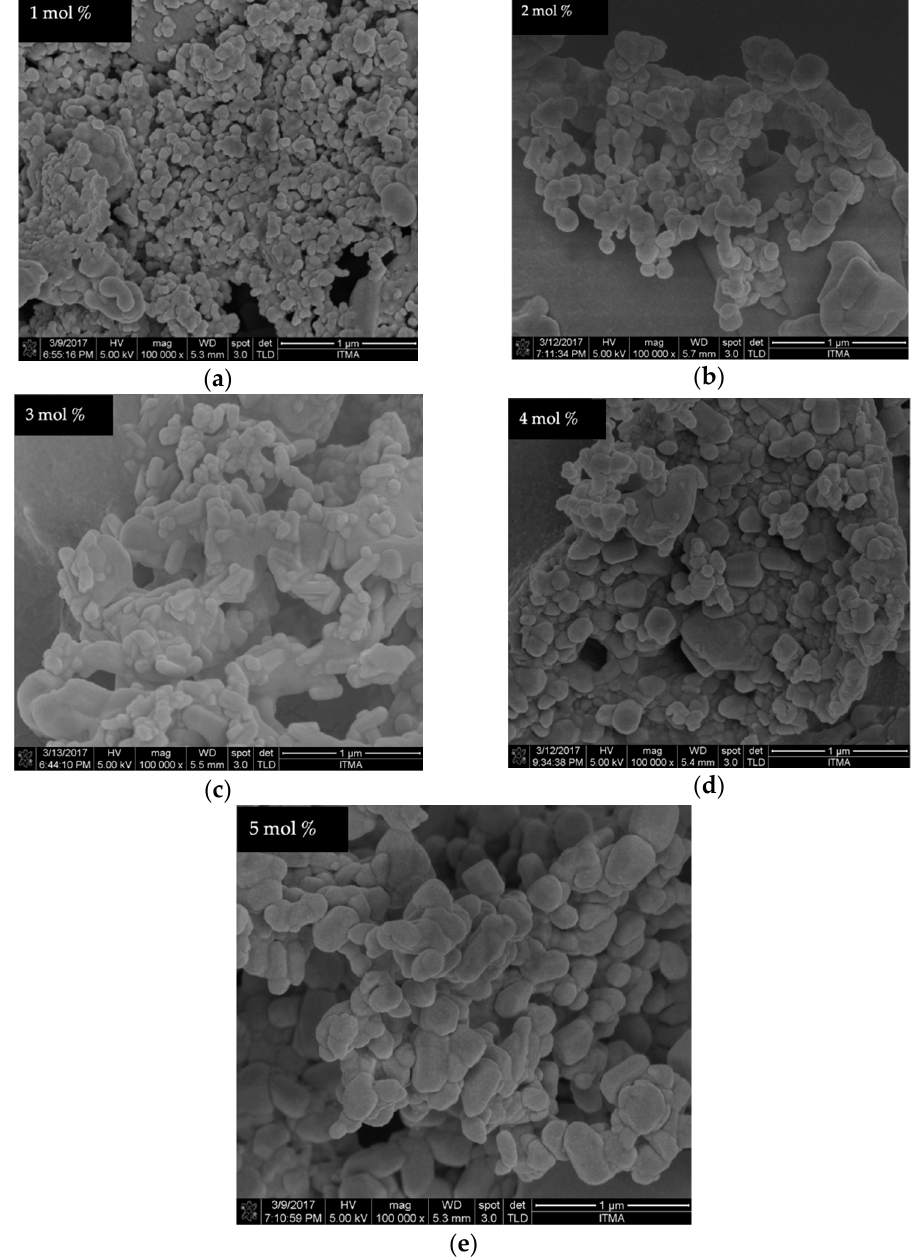
Figure 12. FESEM images of willemite NPs calcined at 900 °C with different Ce 3+ doping concentrations; ( a ) 1 mol%, ( b ) 2 mol%, ( c ) 3 mol%, ( d ) 4 mol%, and ( e ) 5 mol%.